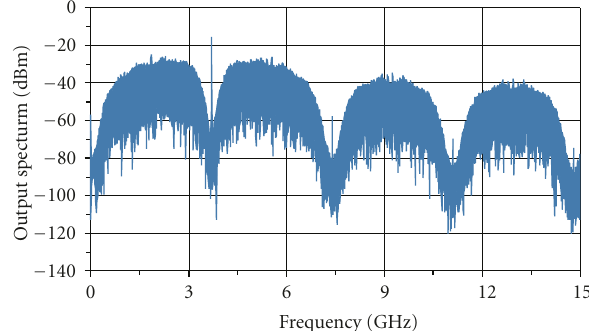
Figure 12: Signal spectrum of the modified polar ΣΔ architecture ( f ΣΔ = 3 .